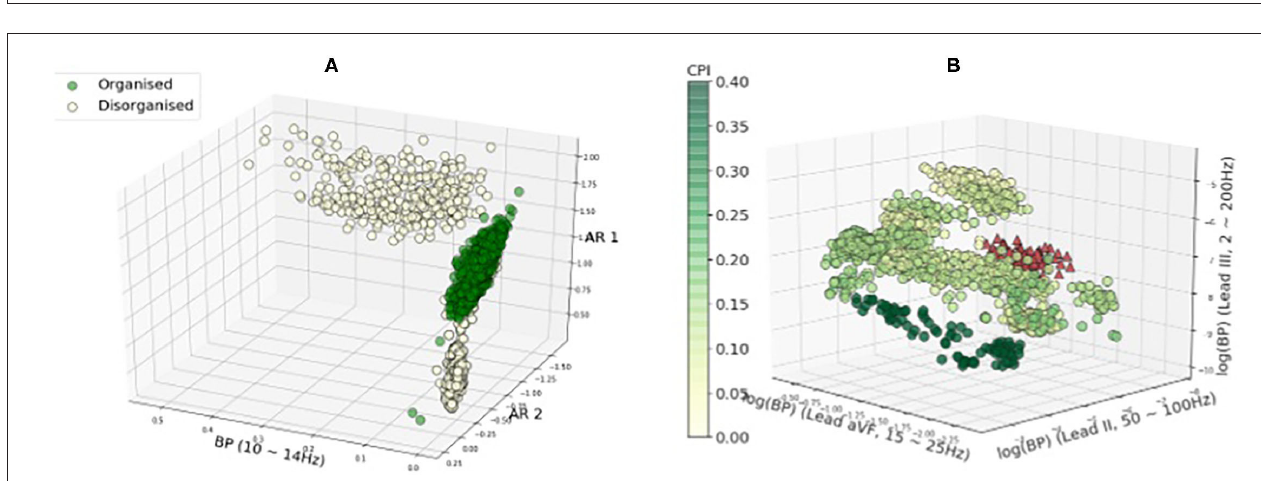
FIGURE 6 | Confusion matrices of the binary classification of the fibrillatory organisation level of the rat VF and clinical AF data. (A) Rat VF ECG, segment level. (B) Rat VF ECG, Subject level. (C) Clinical AF ECG, segment level. (D) Clinical AF ECG, subject level.